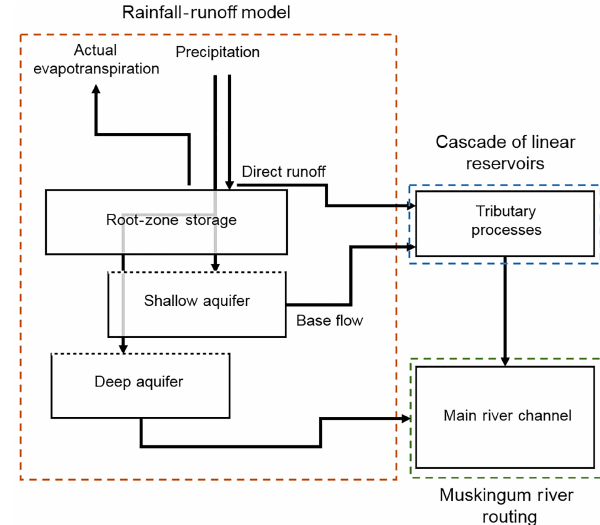
Figure 5. Flow chart of the hydrologic–hydrodynamic model along with the two main modifications to the Zhang et al. (2008) rainfall– runoff model: the deep aquifer and the tributary